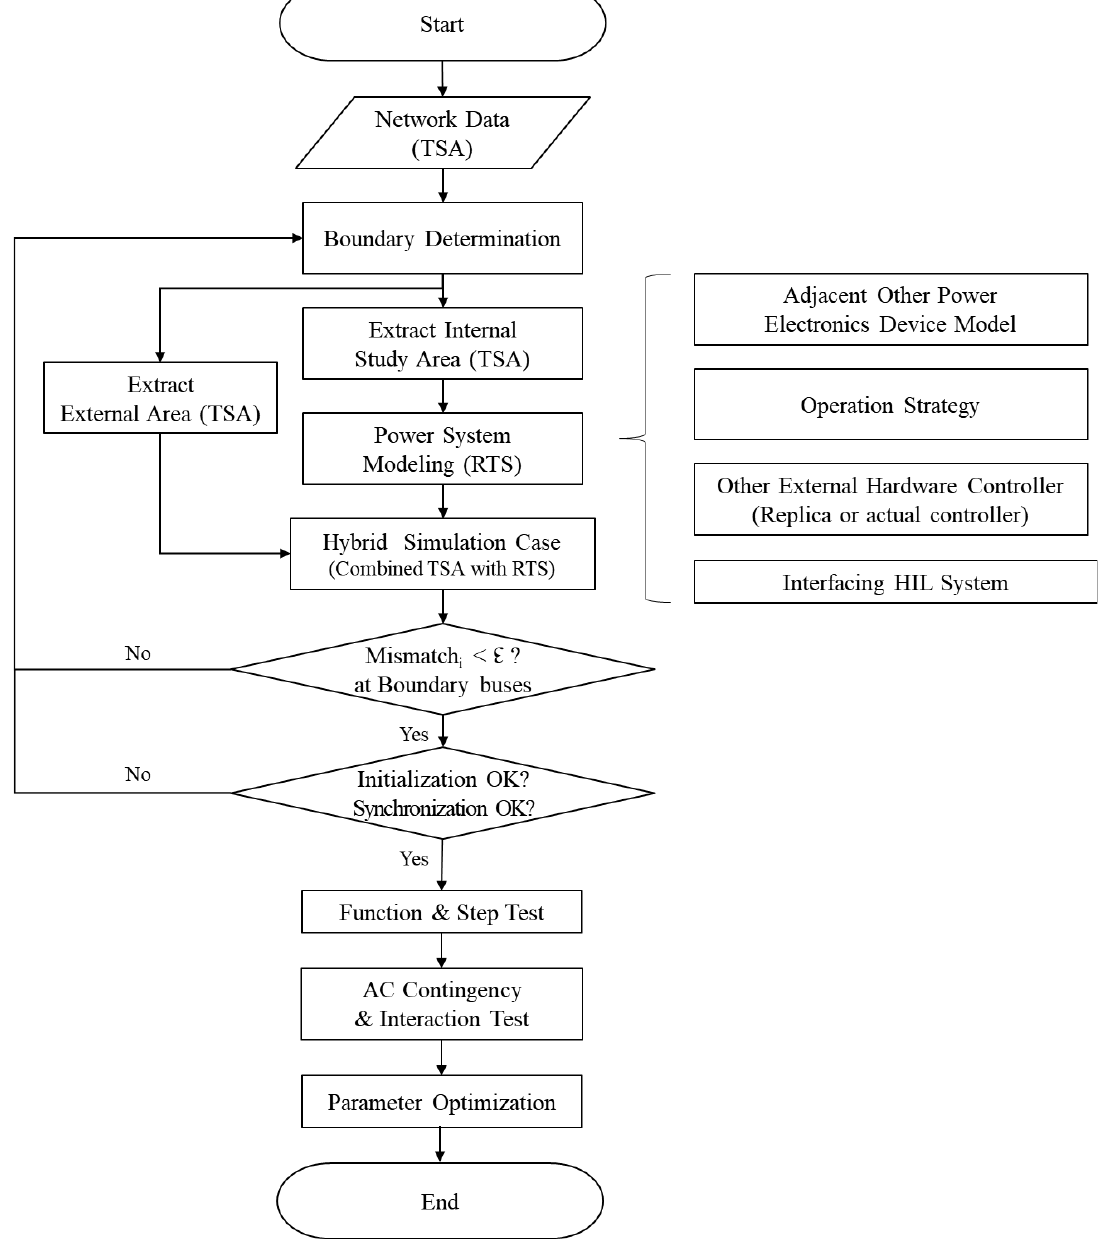
Figure 5. The overall procedure of RTHS for HILS-DPT.